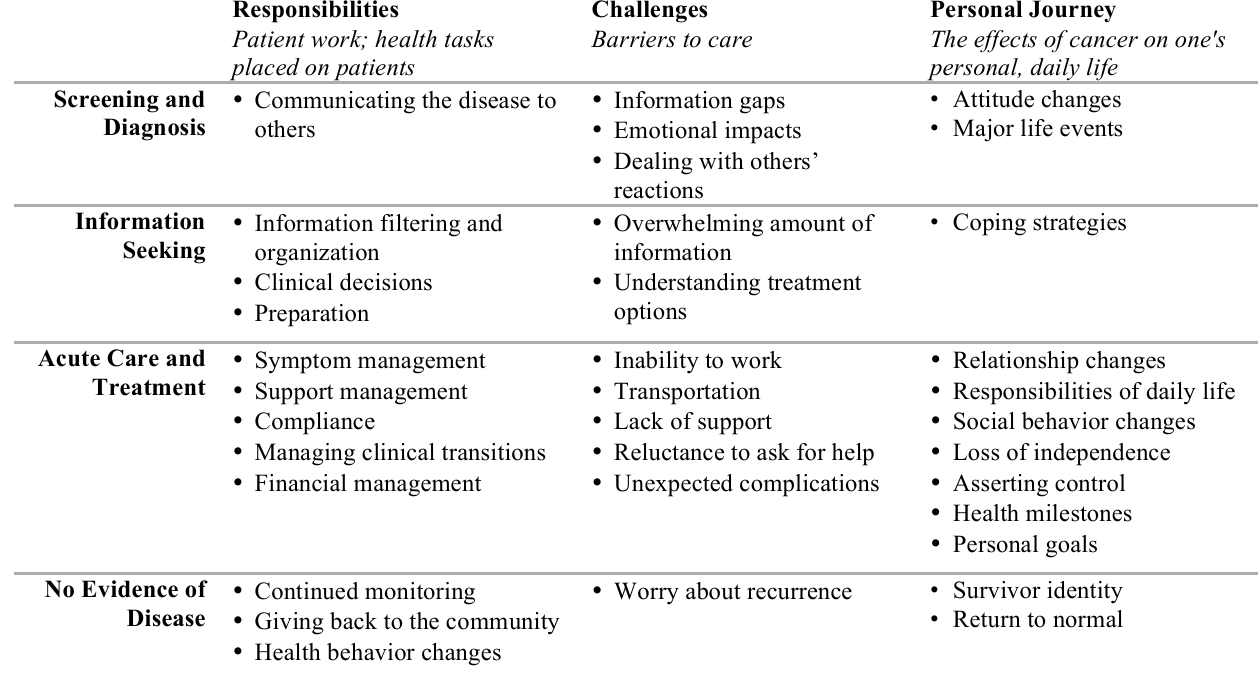
Figure 2. The cancer journey framework, representing the patient-centered cancer